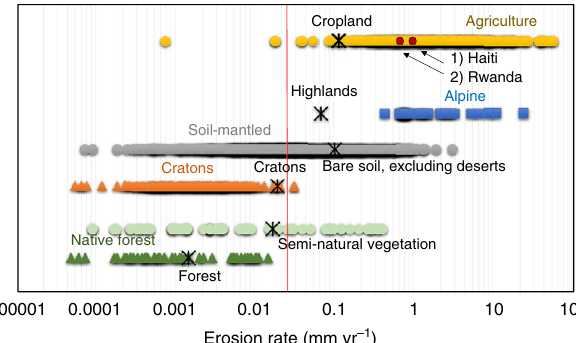
0.00001 0.0001 Fig. 6 Comparison of measured and modelled erosion rates. Representation of soil erosion rates measured on agricultural fi elds under conventional agriculture ( n = 779), geologic erosion rates measured on alpine terrain ( n = 44), soil-mantled landscapes ( n = 1456), low gradient continental cratons ( n = 218), grassland and scrublands ( n = 63), native forests ( n = 46) and averages of our predictions (indicated by an asterisk). Large parts of the measured data come from the study of Montgomery 8 integrated with data from other meta-analysis studies. The vertical red line indicates average value of soil erosion. The red dots refer to averages soil erosion rates modelled for two country highly susceptible to water erosion (Haiti and